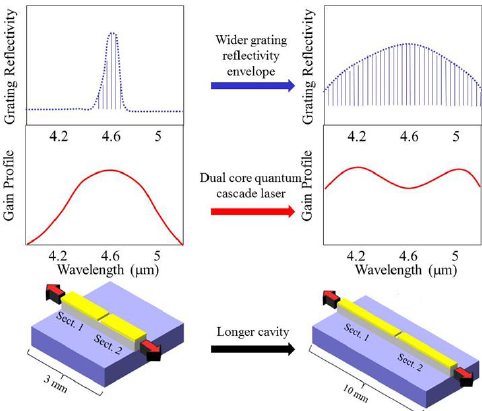
Figure 1. Schematic evolution of original sampled grating distributed feedback (SGDFB) quantum cascade laser (QCL) to a broadband dual core SGDFB.